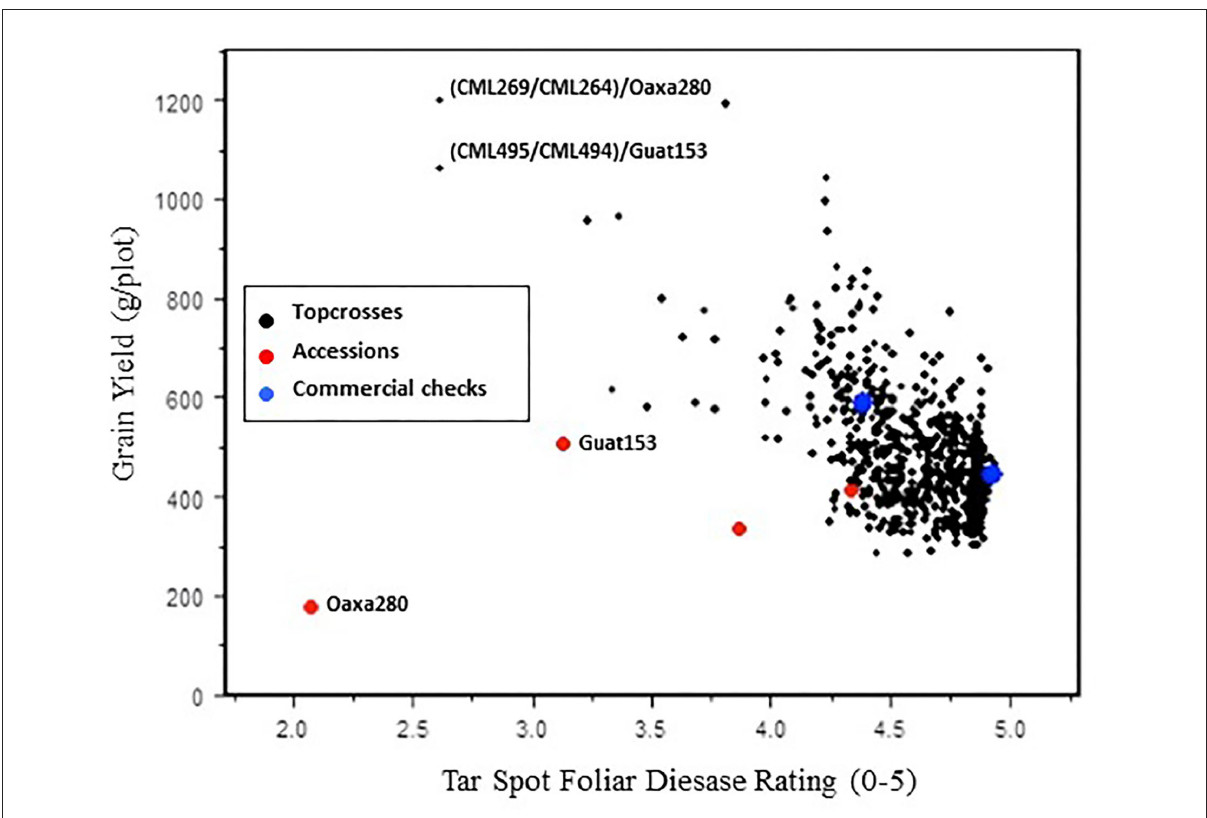
FIGURE2 Relationship between the TSC (tar spot complex) foliar disease rating and the grain yield for accession topcrosses, accessions per se , and commercial checks evaluated in 2012. TSC ratings were plotted using second foliar ratings (Ceballos and Deutsch, 1992 scale 0–5) as an average of 6 plant scores per entry. Grain yield is adjusted to 12.5% humidity.